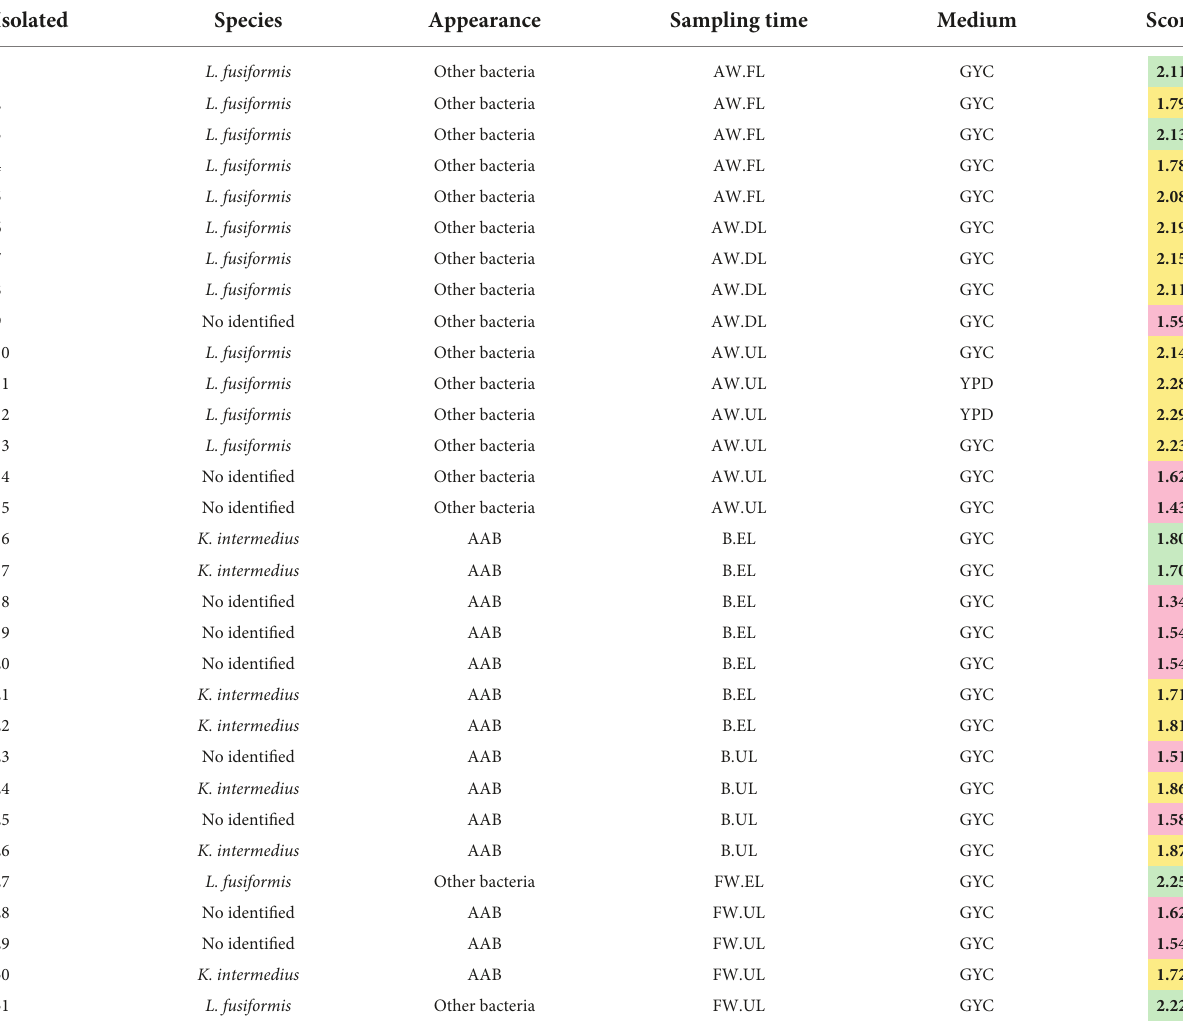
TABLE 2 List of selected vinegar isolates for identification by MALDI-TOF MS analysis.